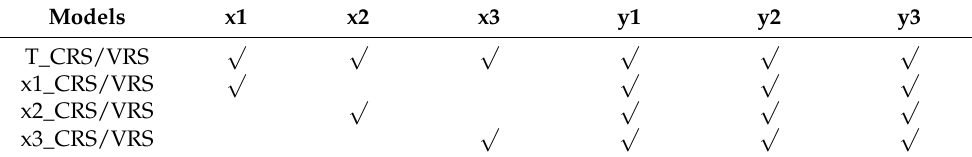
Table 3. Hospital efficiency